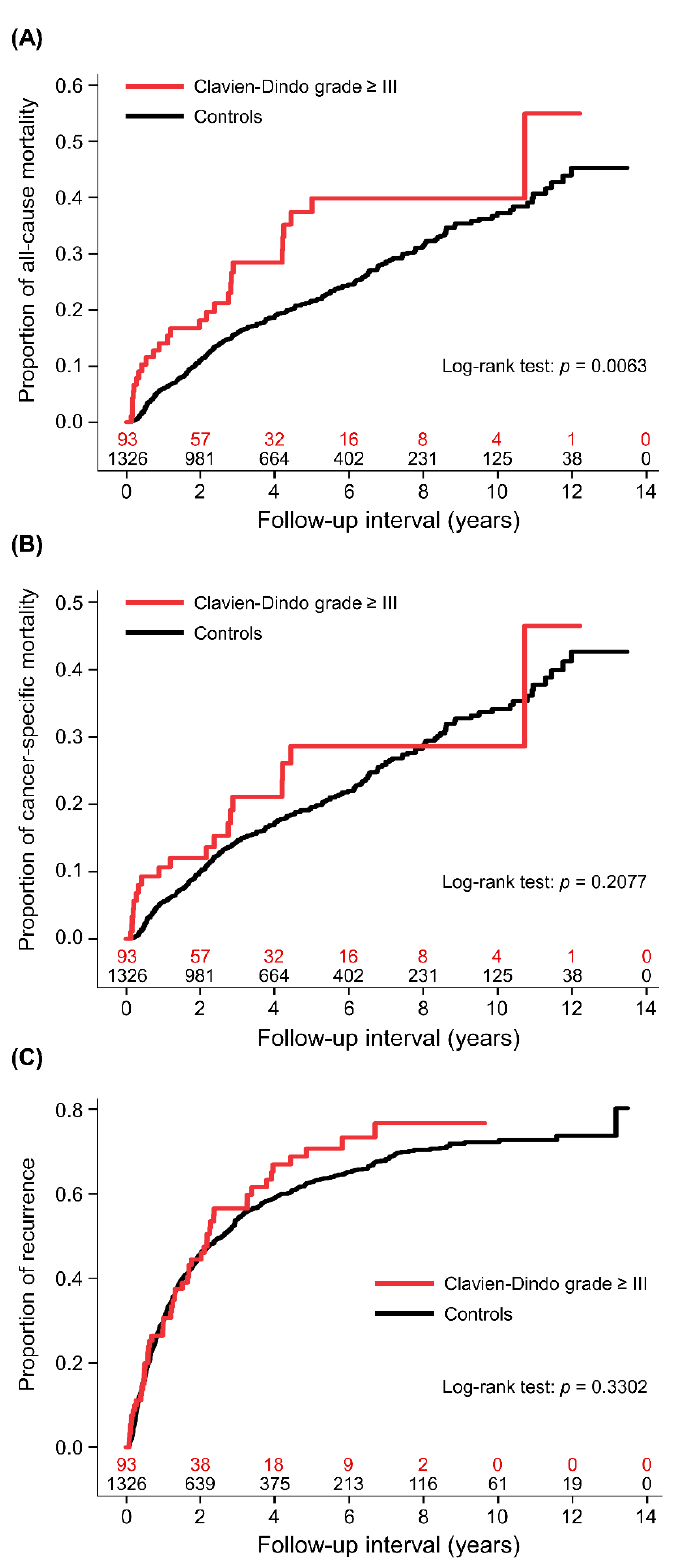
Figure 2. Cumulative incidences of patients with high-grade complications and controls. ( A ) All- cause mortality, ( B ) cancer-specific mortality, and ( C ) cancer recurrence.